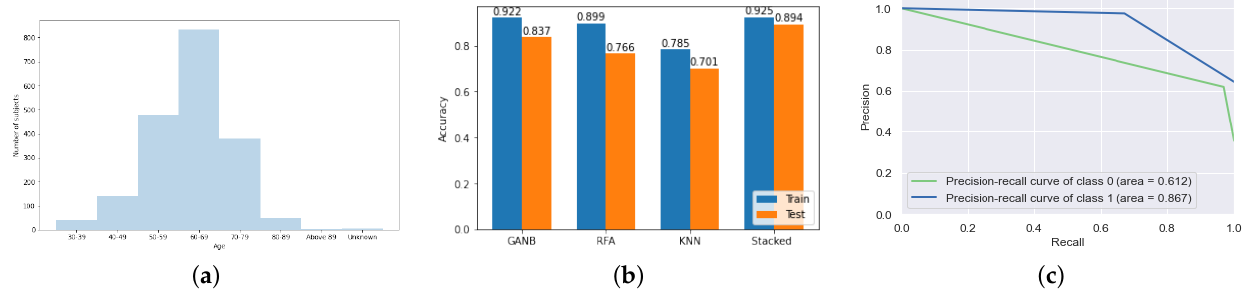
Figure 5. ( a ) Age distribution of participants in the study. ( b ) Comparative analysis of different classifiers. ( c ) Cumulative gain for the stacked ML model.